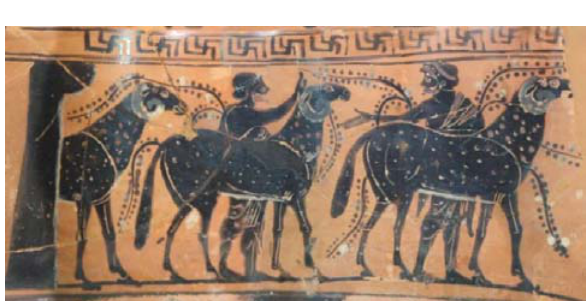
nd smoothing interventions were made (Fig. 10).